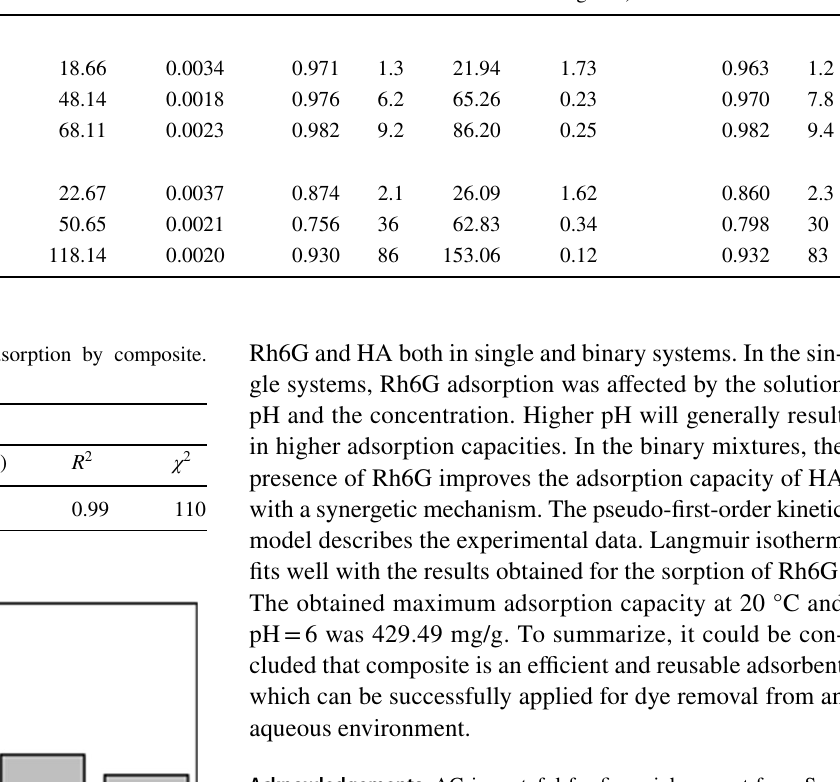
Table 4 Pseudo-first-order and pseudo-second-order parameters for Rh6G and HA adsorption by composite in binary systems at various initial concentrations